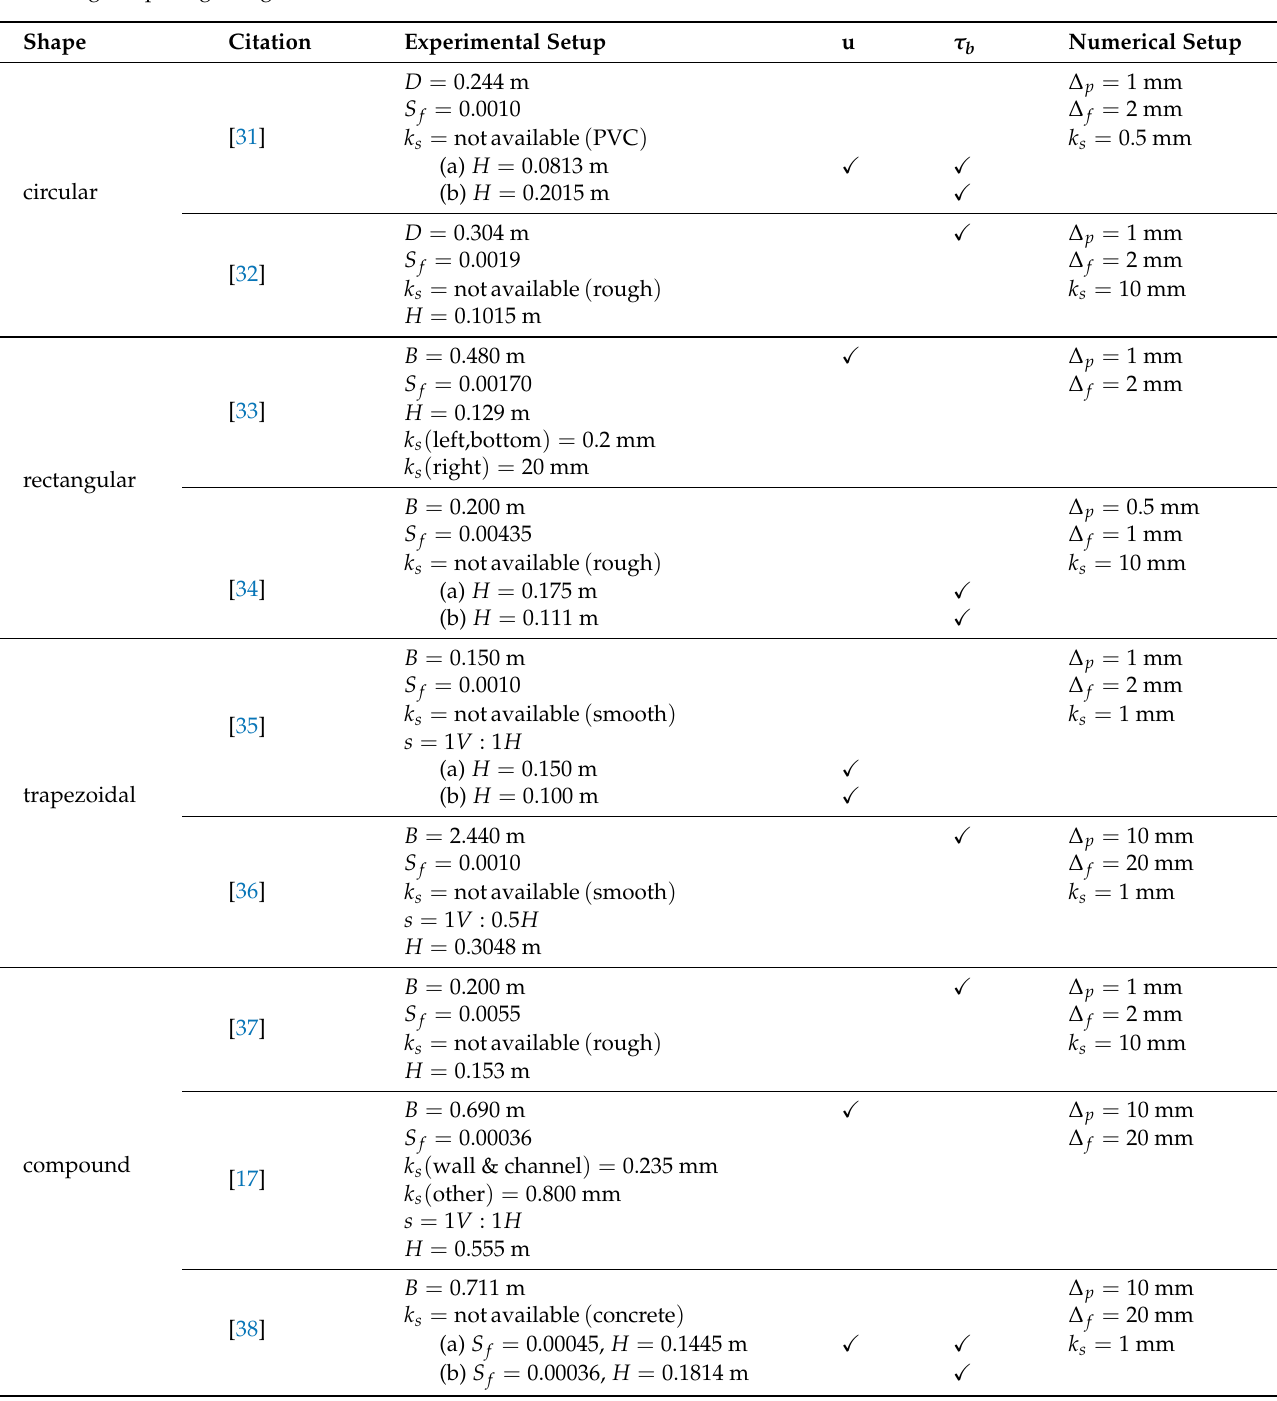
Table 1. Experimental cases employed for comparison purpose, where D ≡ is the pipe diameter (circular), S f ≡ is the longitudinal slope, k s ≡ is the roughness, H ≡ is the water depth, B ≡ is the base width, s ≡ is the sidewall slope (trapezoidal), B w ≡ is the water surface width (compound), ∆ p ≡ is the grid spacing along the wetted perimeter and ∆ f ≡ is the grid spacing along the free